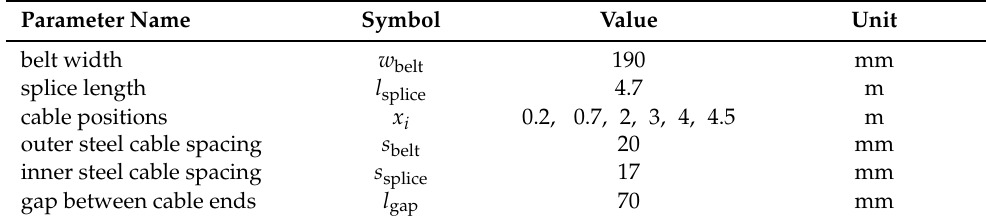
Figure 4. Geometry of the splice: ( a ) full view of the splice and ( b ) closer view of one part of the splice. Note that the lateral cable distance is smaller within the splice compared to outside the splice. Table 2. Parameters of the